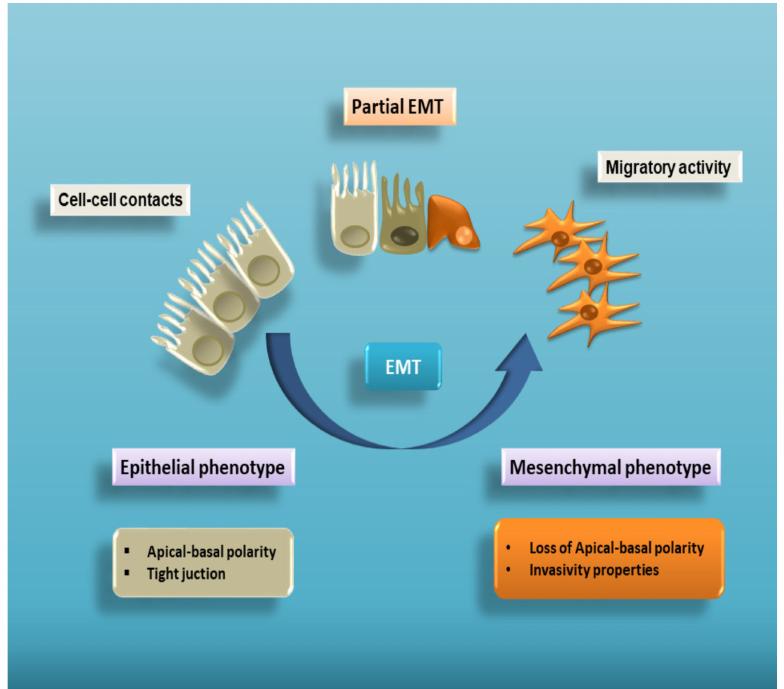
Figure 1. Cell plasticity in EMT. EMT is a multistep process allowing epithelial cells to lose their apical–basal polarity and disassemble epithelial cell–cell contacts. Through a complex cellular and molecular program, these cells progressively acquire mesenchymal features that include cytoskeleton reorganization and a proteolytic capacity favouring cell motility. Therefore, EMT proceeds through multiple partial intermediate states, collectively known as the partial EMT. A partial EMT takes place physiologically during wound healing and leads to an intermediate phenotype that presents some epithelial features, but also characteristics of mesenchymal